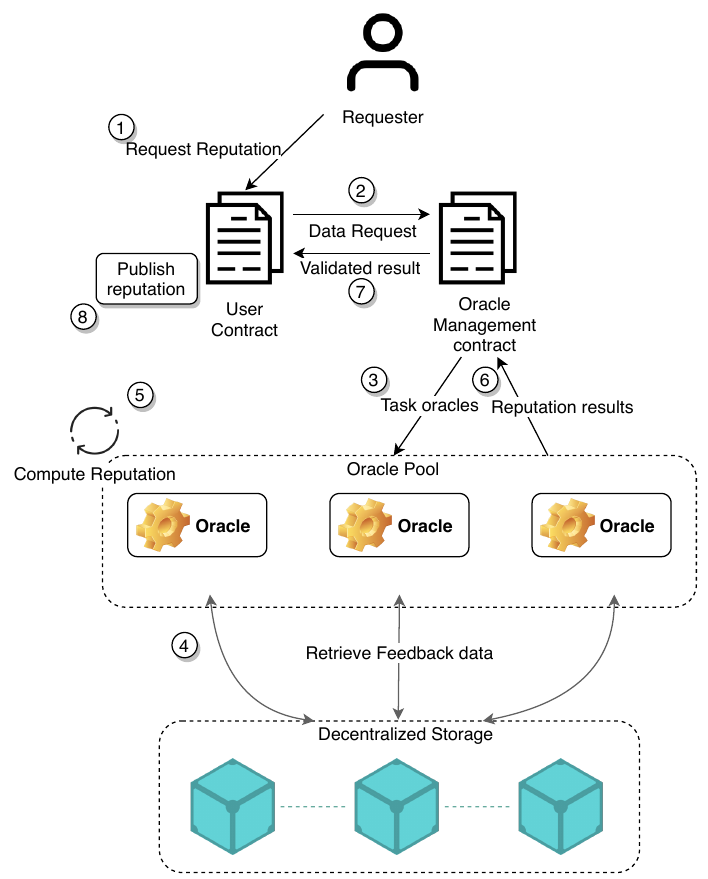
Figure 3. Oracle utilization